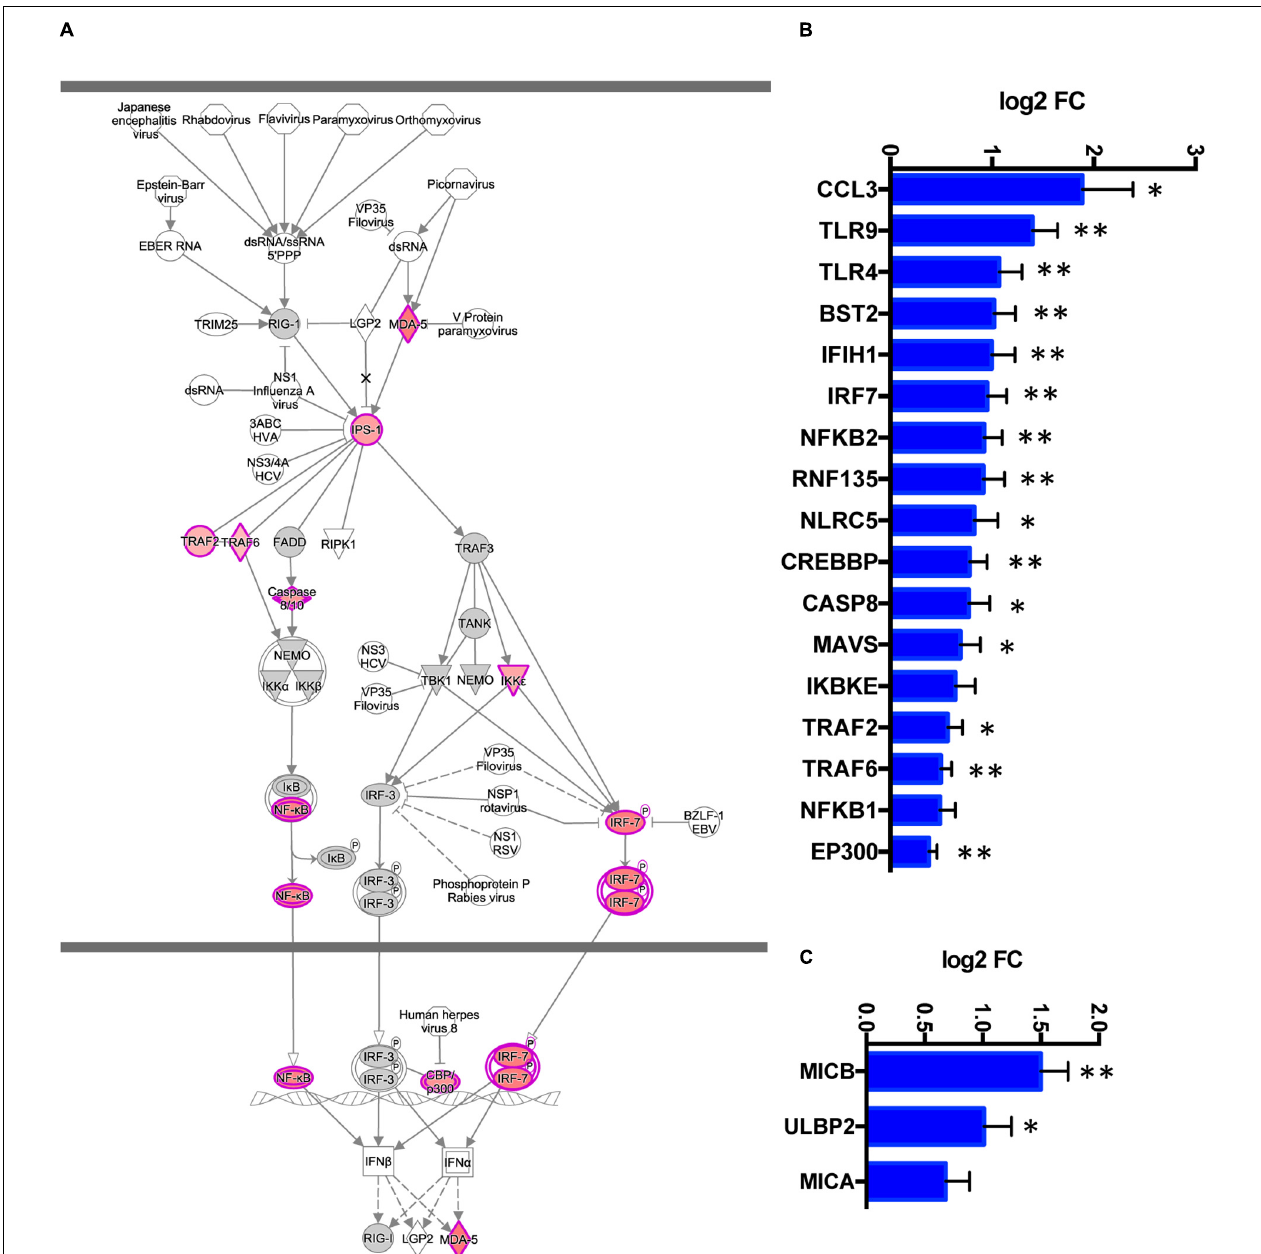
FIGURE 4 | TREM2 R47H AD features upregulated interferon type I response and MHC class I-like NKG2D ligands. (A) Role of RIG1-like receptors in antiviral innate immunity, Ingenuity Pathway Analysis-generated diagram shows perturbed gene expression in TREM2 R47H AD brains. Red denotes upregulated genes; gray, not changed compared to control brains; white, not assessed. Perturbed expression (FDR < 0.1) of IFN I type response/antiviral genes (B) and MHC class I-like NKG2D ligands. (C) Data are presented as mean ± SD ( ∗ adj p -value < 0.05; ∗∗ adj p -value < 0.01); y -axis displays log2 (FC, fold changes) value.